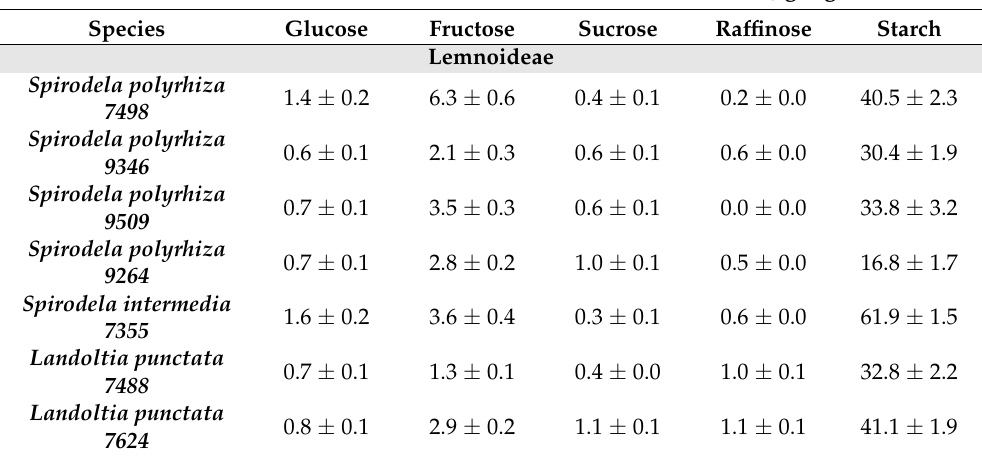
Table 2. Non-structural carbohydrates composition of 21 ecotypes of duckweeds. Data represented by the mean ± standard error ( n =